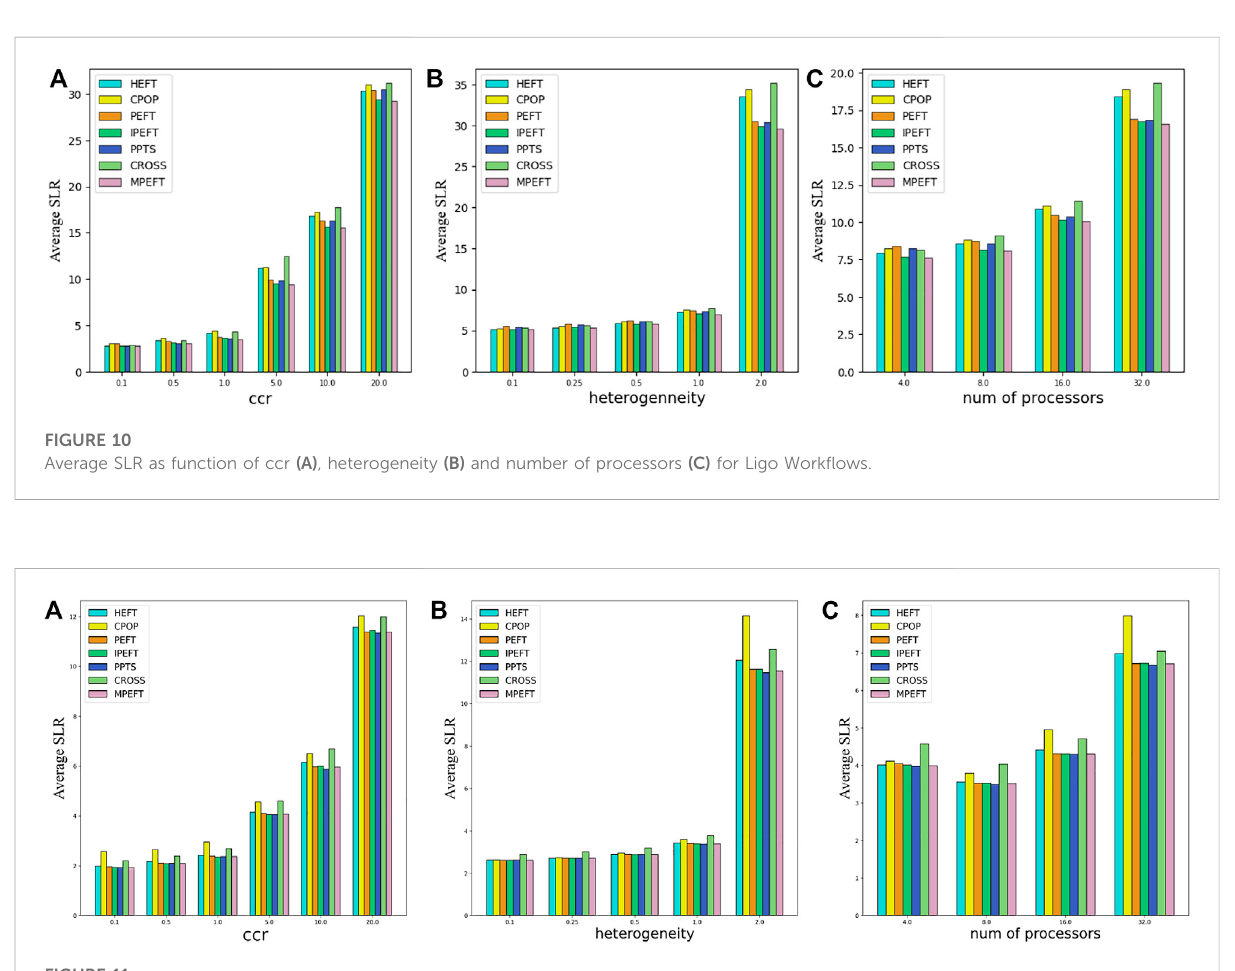
Frontiers in Environmental